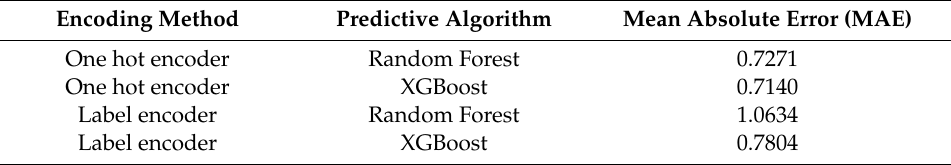
Figure 7. Ranking of feature importance on severity prediction of teen driver crashes in West Texas rural areas. Table 1. The prediction accuracy of the developed four models.